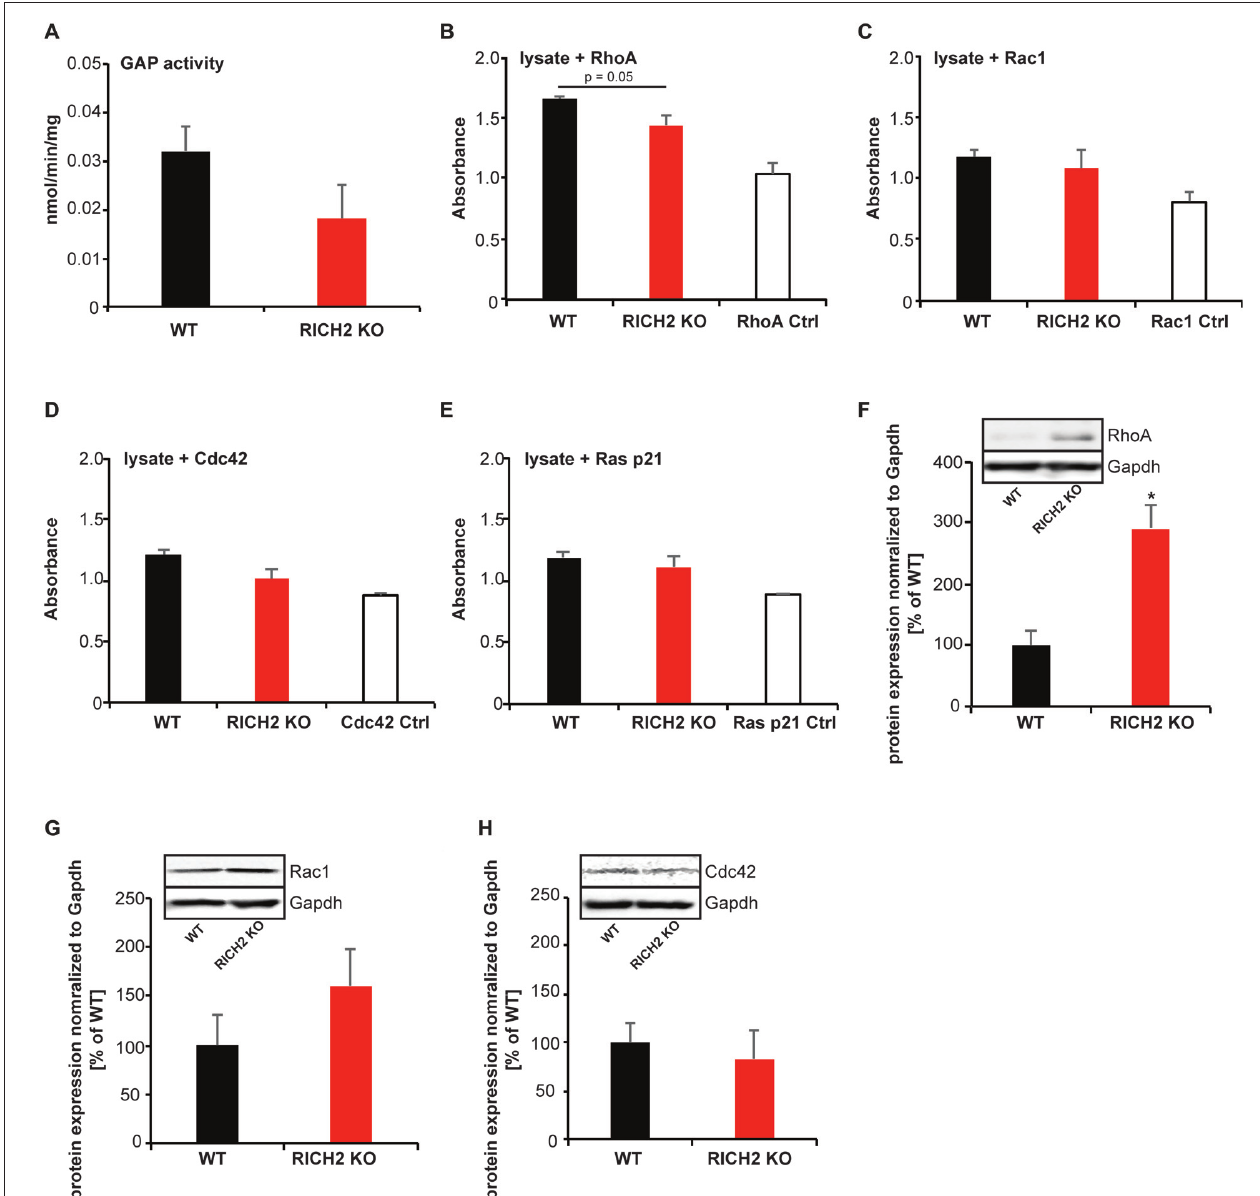
FIGURE 5 | Altered Rho GTPase signaling in amygdala of RICH2 KO mice. (A) Comparison between the GTPase activating protein (GAP) activity of the P2 lysates from WT and RICH2 KO mice. The GAP activity is measured in nmoles/min/mg of small G-protein. First a standard curve is made using the absorbance of KH 2 PO 4 at different concentrations, later the absorbance of WT and RICH2 KO lysates are plotted on the graph. The GAP activity is higher for WT lysates compared to RICH2 KO lysates. (B) In the presence of the small G protein RhoA, the absorbance of WT lysates is higher than that of RICH2 KO lysate, which indicates that RICH2 is acting as a GAP for RhoA in amygdala. (C) There is no difference between the absorbance of WT and RICH2 KO lysates in the presence of RAC1 and CDC42 (D,E) Like RAC1 and CDC42, RAS p21 is not a target G protein for RICH2 in amygdala as there is no difference in the absorbance of WT and RICH2 KO lysates in the presence of RAS p21. (F) Western blot analysis of amygdala P2 lysates reveals that expression of RhoA is significantly higher in RICH2 KO lysates, in comparison with WT lysates (Unpaired t -test, p = 0.0508, n = 3). (G,H) Western blot analysis revealed no alteration in the expressions of Rac1 (G) and Cdc42 (H) between WT and RICH2 KO using amygdala P2